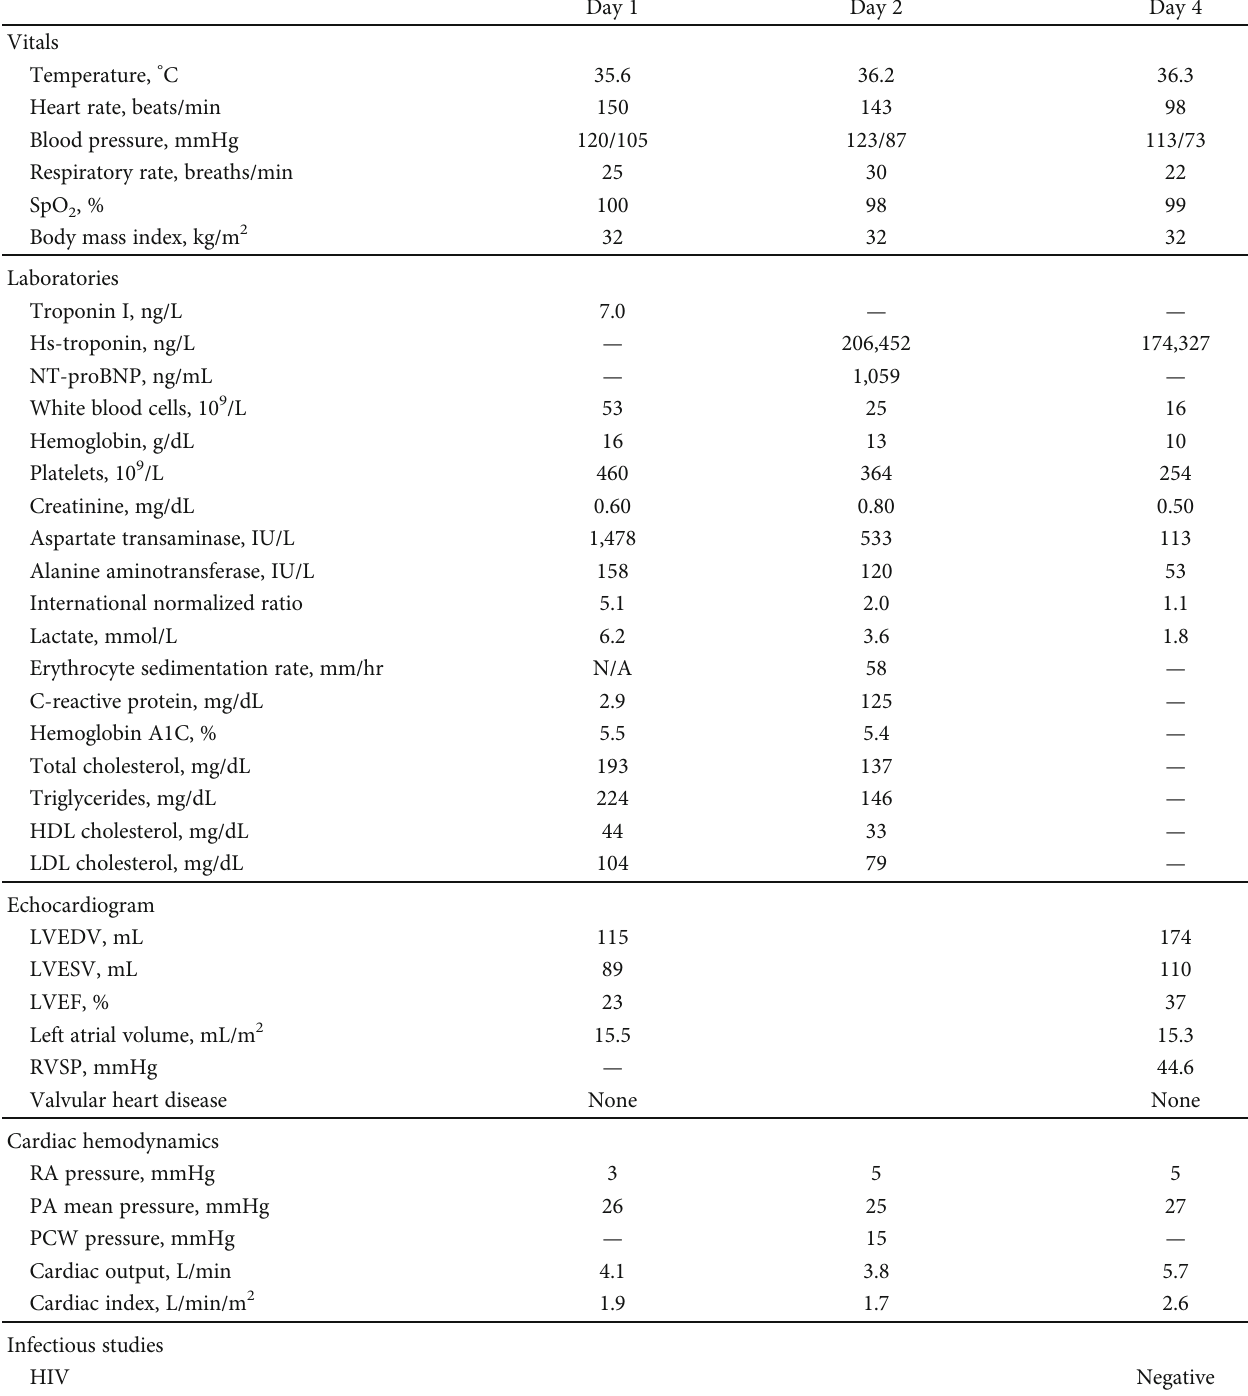
Table 1: Clinical, laboratory, and echocardiographic